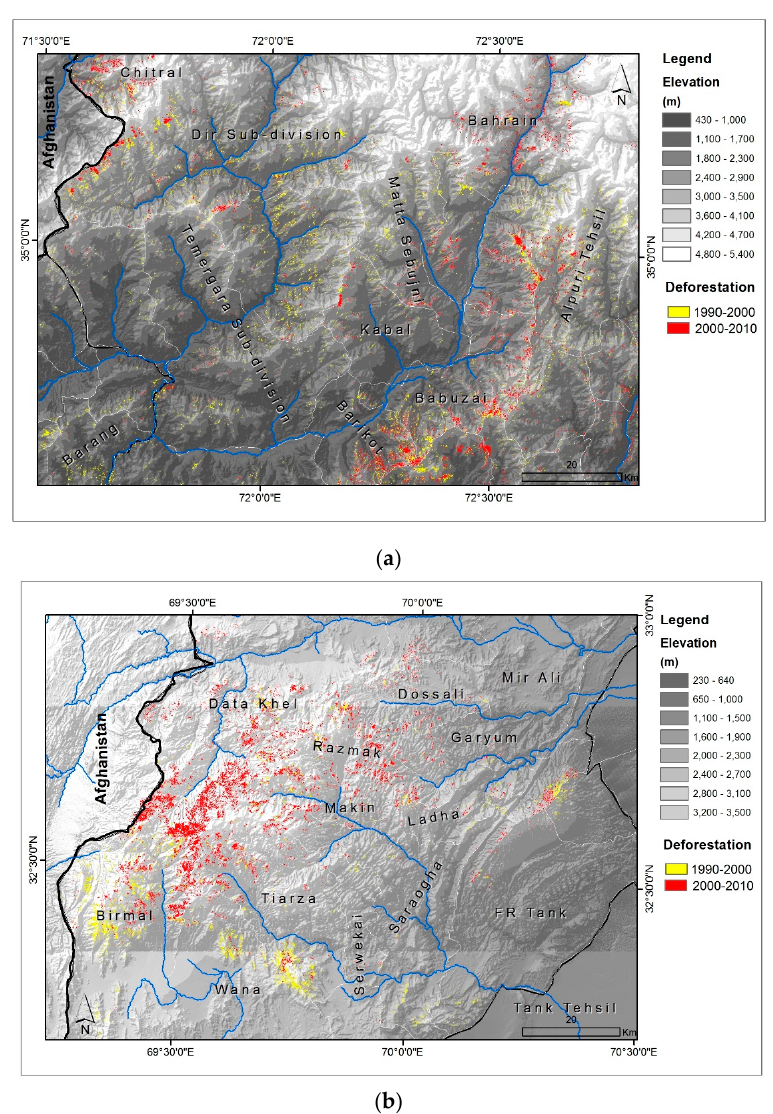
Figure 6. Spatial and temporal patterns of deforestation across two major forest types ( a ) Dry temperate forest in the KP; ( b ) Sub tropical forest in Federally Administered Tribal Areas (FATA).